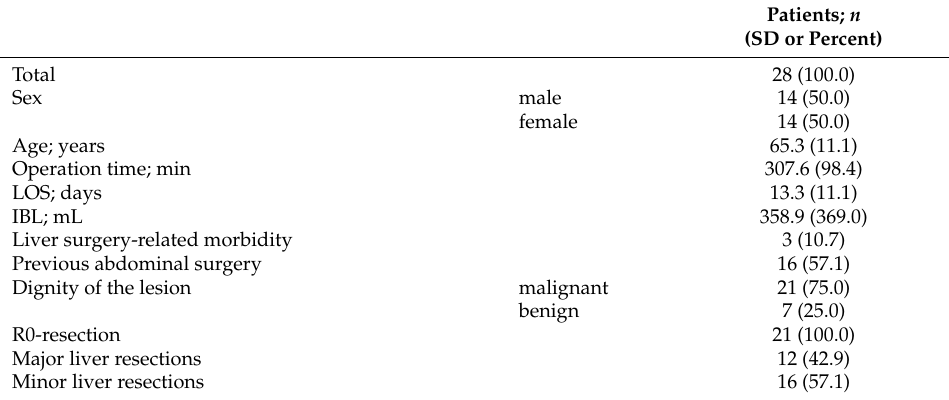
Table 1. Demographics and perioperative outcomes in patients who underwent major and minor robotic liver resection (RLR) using the three device (3D) technique for parenchyma dissection.